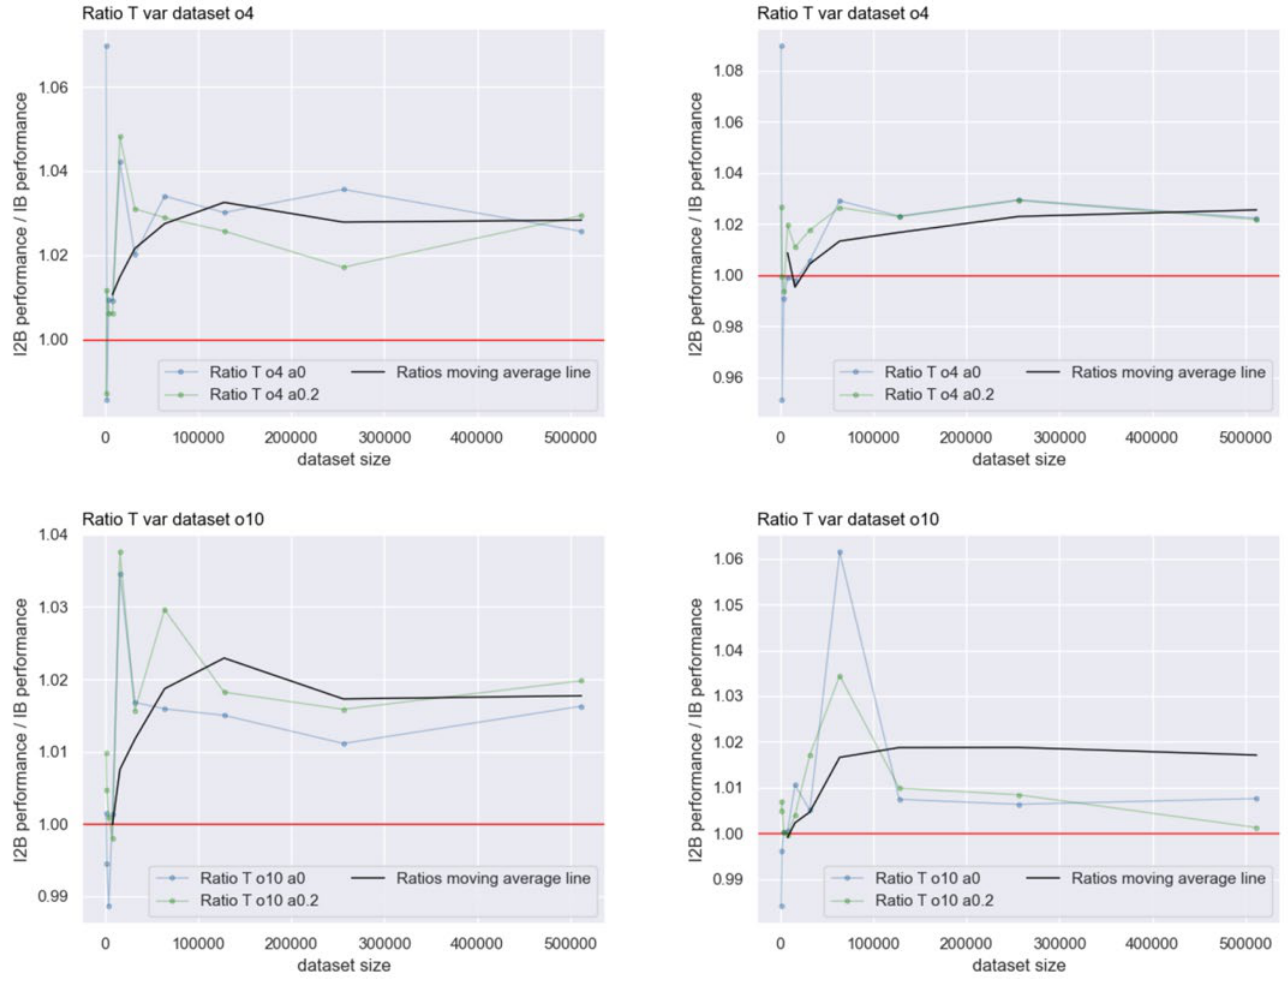
Figure 4. Ratio plots of the tree construction test (T), for the different orders (4, 10 and 20), in both